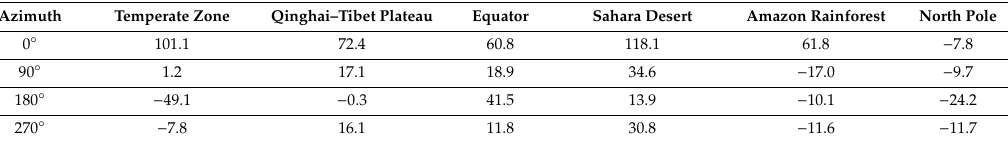
Table 3. The biases of the slant total delays (STDs) from Vienna mapping function (VMF1) with respect to the STDs from ray tracing at di ff erent azimuths.